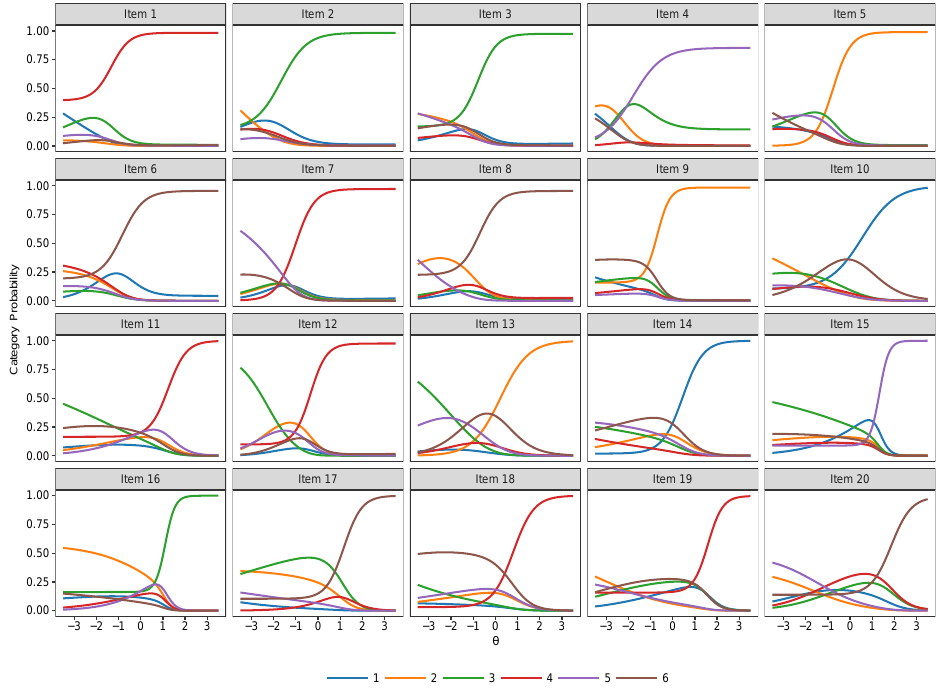
Figure 7. Item category curve plots of the 4-Parameter Nested Logit (4PNL) model. The marginal estimates of empirical reliability for all the nominal models were satisfactory, as they were 0.857 for the Nominal Response model, 0.867 for the 2PNL model, 0.887 for the 3PNL model and 0.888 for the 4PNL